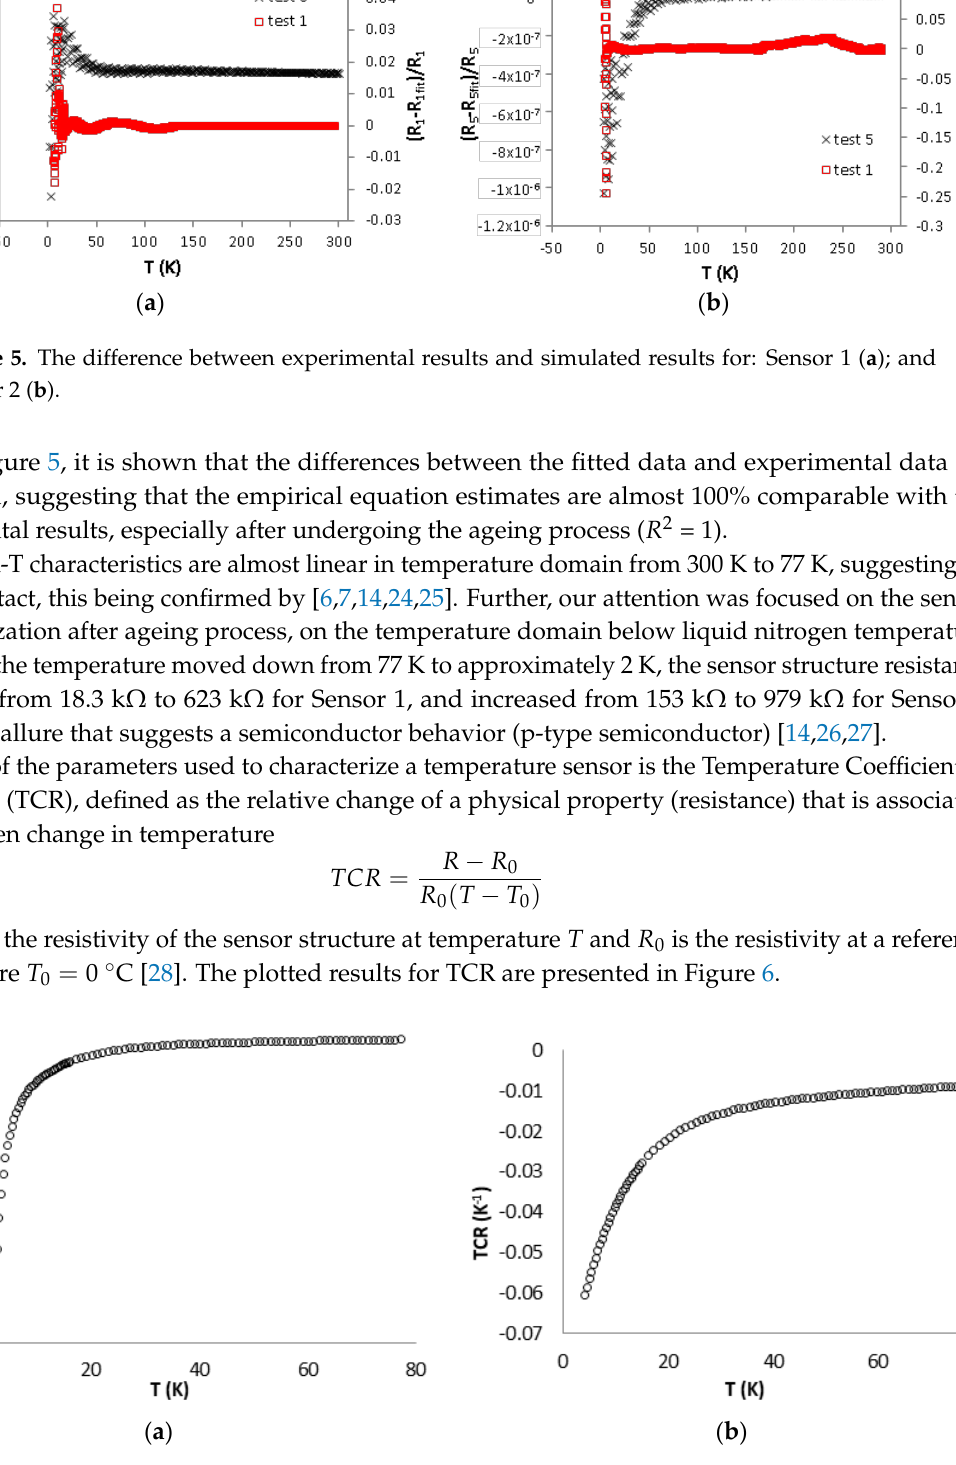
Figure 6. Temperature coefficient of resistance for: Sensor 1 ( a ); and Sensor 2 ( b ).